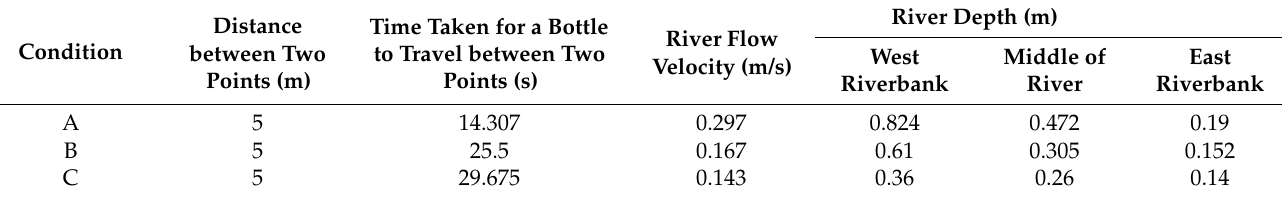
Table 3. Parameters required for river flow velocity